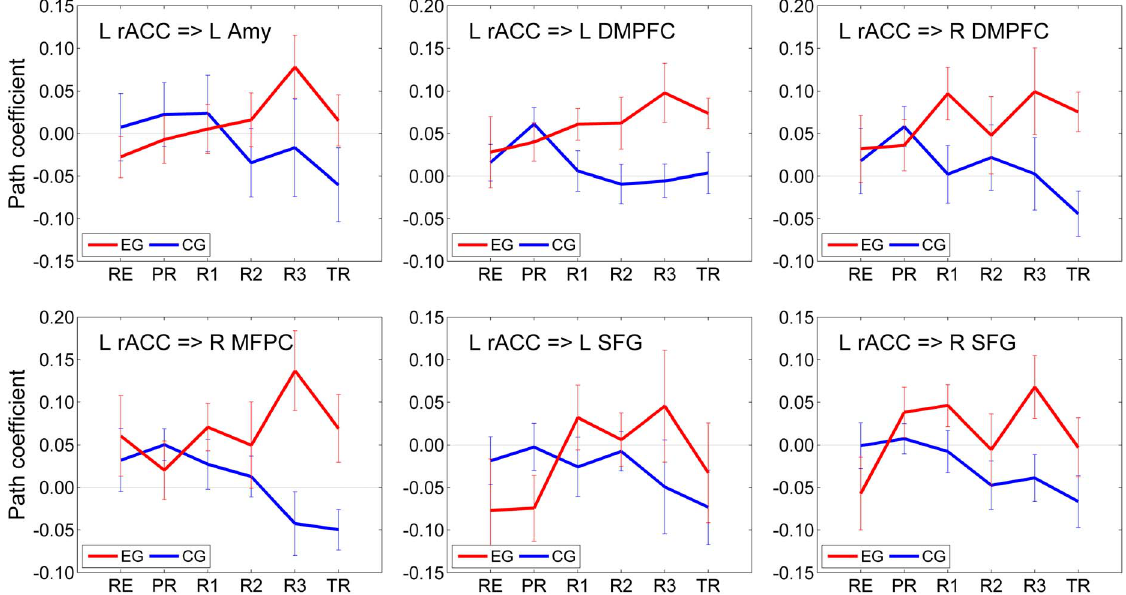
Figure 4 . Effects of the rACC on the other six network regions suggested by the multivariate VAR analysis. Average path coefficient values (mean 6 sem) describing the effects of the left rACC on the other six network regions based on the analysis illustrated in Fig. 3. The results for each of the six experimental runs are shown in red for the experimental group (EG) and in blue for the control group (CG). doi:10.1371/journal.pone.0079184.g004 PLOS ONE |